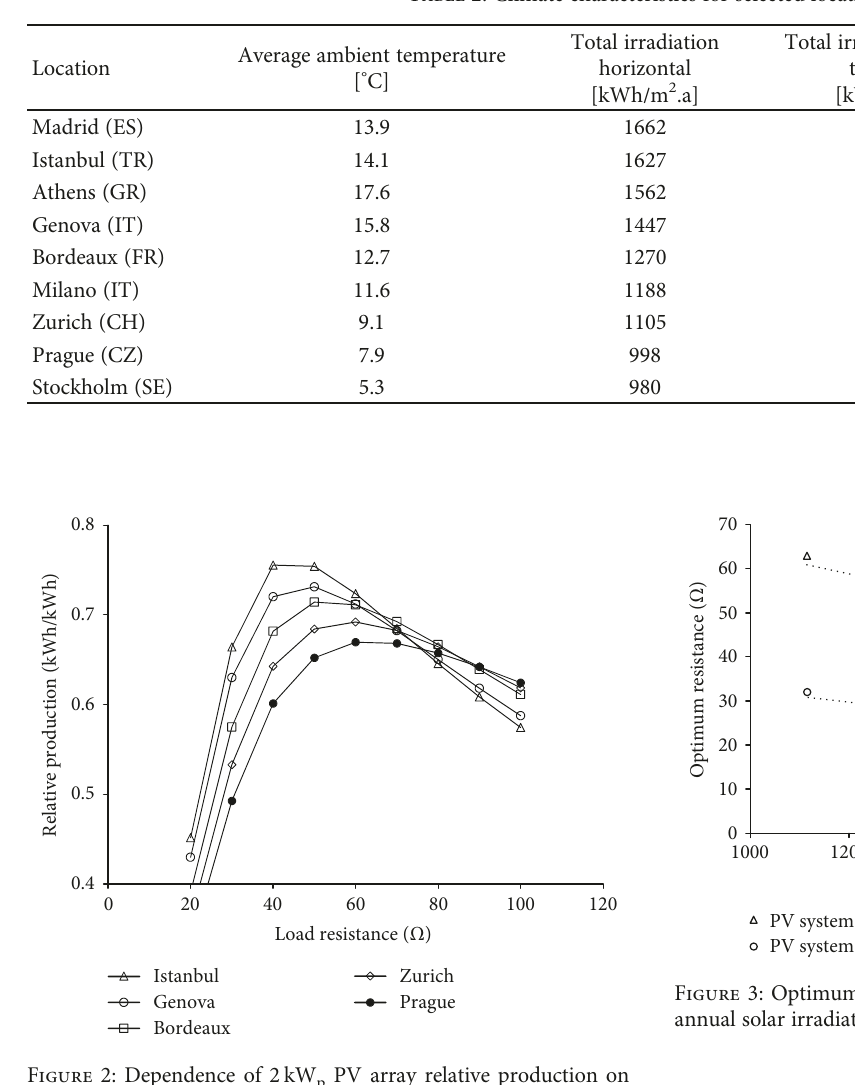
Figure 2: Dependence of 2 kW PV array relative production on p load resistance for selected locations.